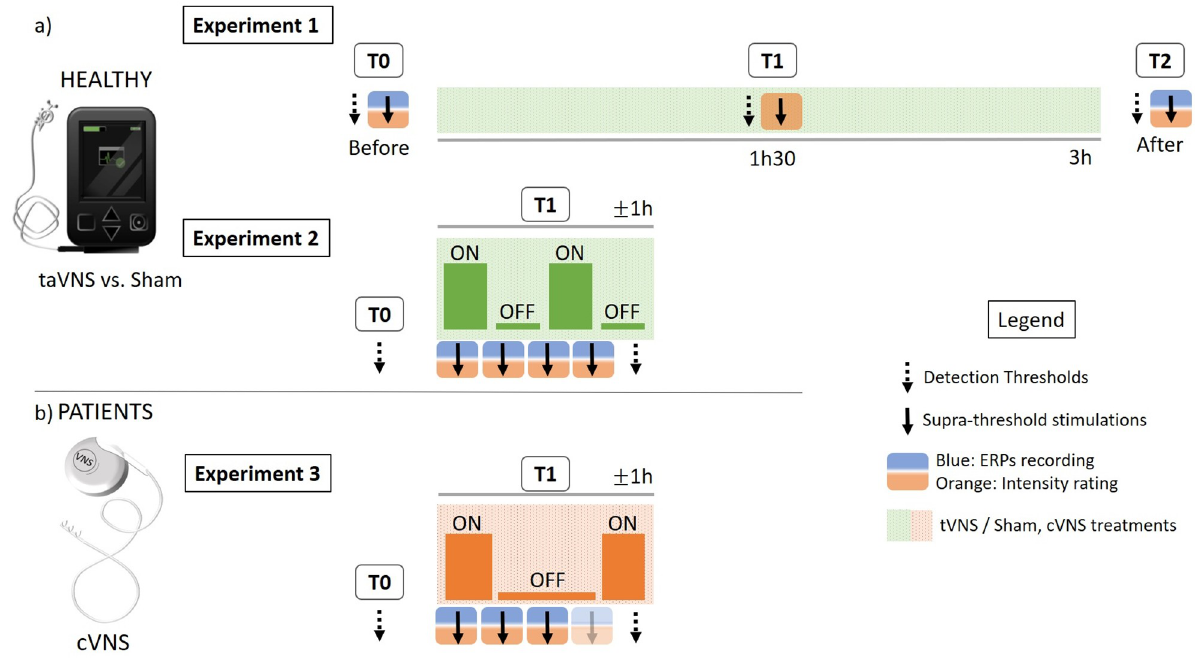
Fig 2. Overview of all experiments. a) Experiments conducted in healthy subjects. Each participant underwent a randomized protocol, during which non-invasive taVNS and sham stimulations were delivered in a 2-day cross-over design. Experiment 1 focused on the somatosensory effects induced after 3h of taVNS/sham stimulation, while Experiment 2 focused on the immediate effects of the OFF/ON phases of the duty cycle (30s ON/30s OFF). b) Experiment 3 was conducted in epileptic patients. The experiment focused on the immediate effects of the OFF/ON phases of the duty cycle (rapid cycling: 30s ON/ 1.1min OFF) of the implanted cervical VNS in a 1-day protocol. Participants completed a minimum of 3 blocks of suprathreshold stimulations, and a fourth depending on tolerability (fading 4th arrow). Abbreviations : ERPs = Event Related Potentials , taVNS = transcutaneous auricular vagus nerve stimulation . cVNS = cervical vagus nerve stimulation T0 = baseline . T1 = during vagus nerve stimulation . T2 = after vagus nerve stimulation .